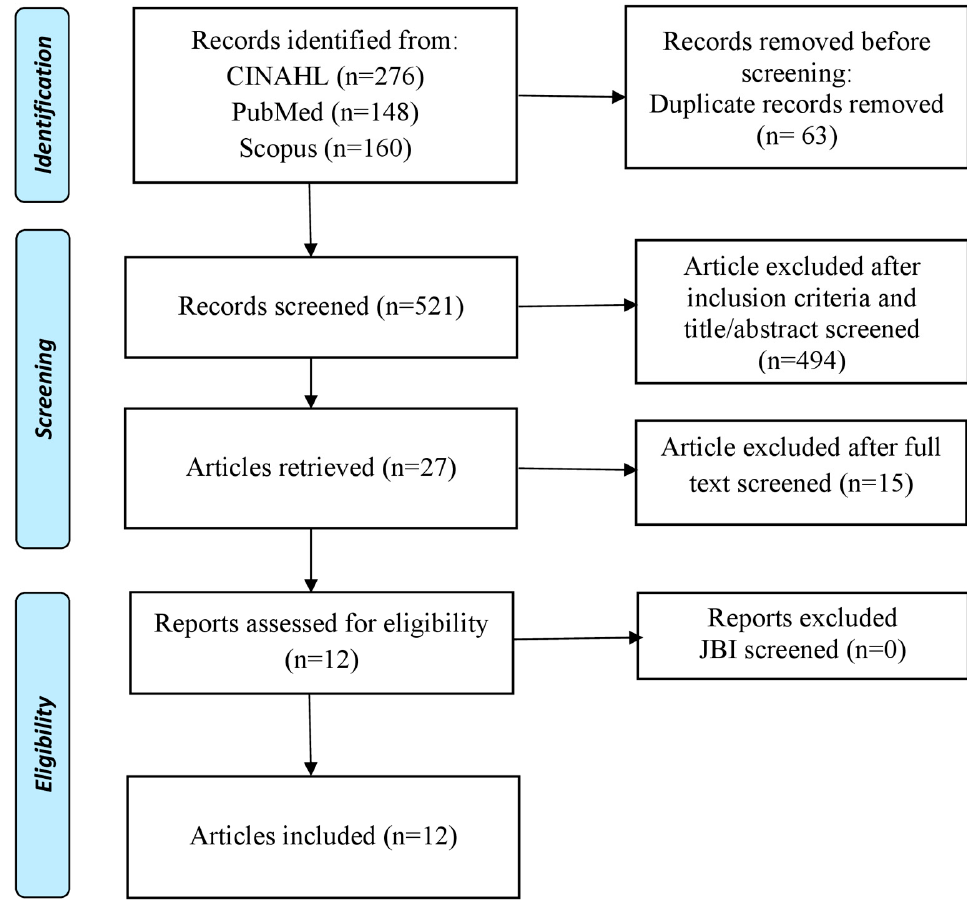
Figure 1. PRISMA Flow Diagram.